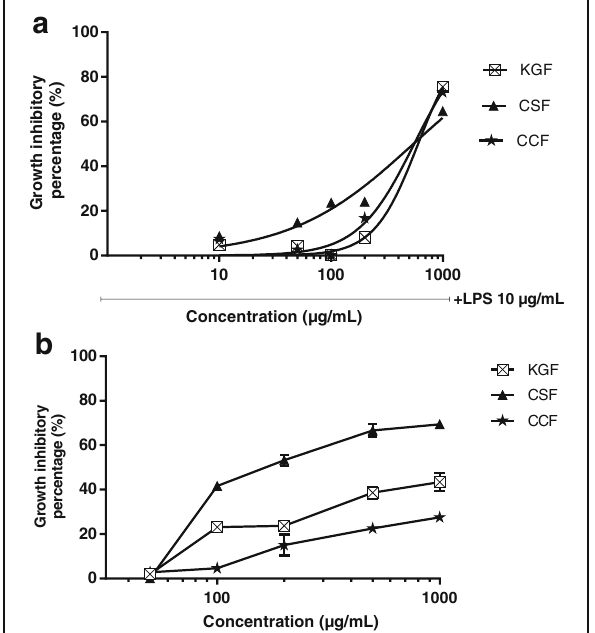
Fig. 1 Cytotoxicity of polysaccharide fractions of Khaya grandifoliola stem bark (KGF), Cryptolepis sanguinolenta (CSF) and Cymbopogon citratus (CCF) leaves on RAW 264.7 macrophages cell lines ( a ) and U87-MG glioblastoma cell line ( b